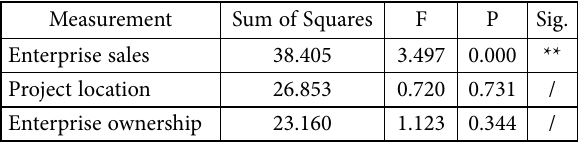
Table 11. One-way analysis of variance of enterprise attributes